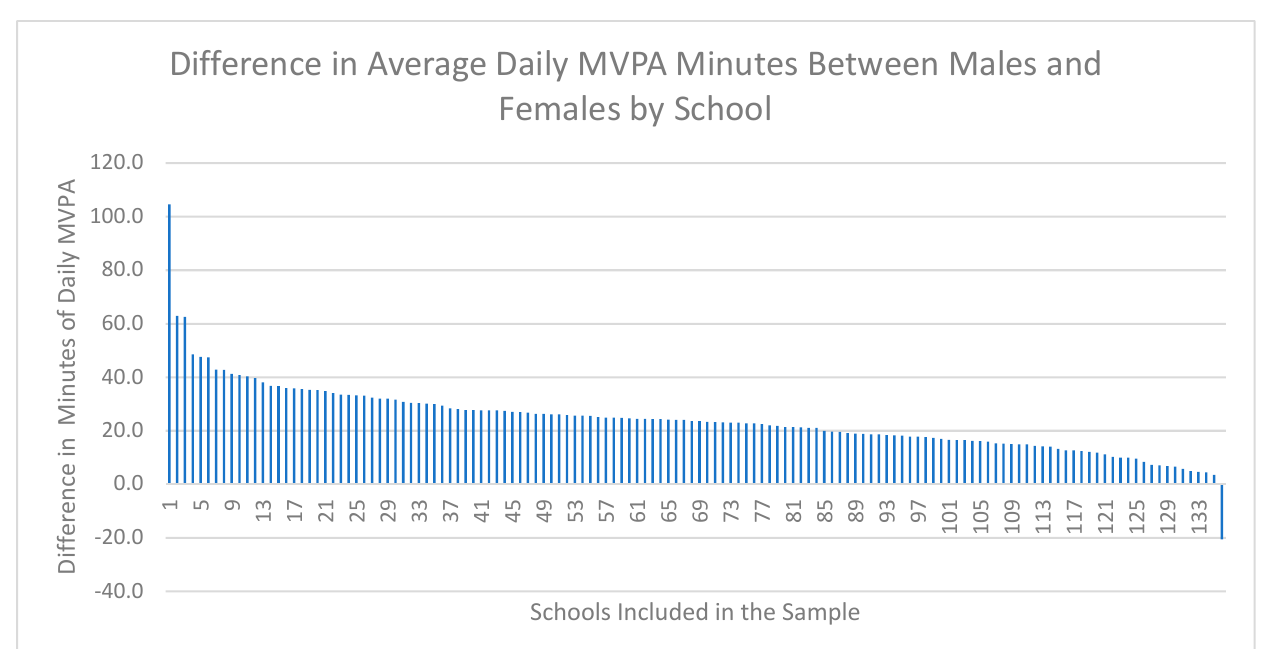
Figure 3. School-level differences between average daily minutes of MVPA for male and female students from Year 7 (2018–2019) of the COMPASS Study. Note: The difference is calculated as the average daily minutes of MVPA for males minus the average daily minutes of MVPA for females.